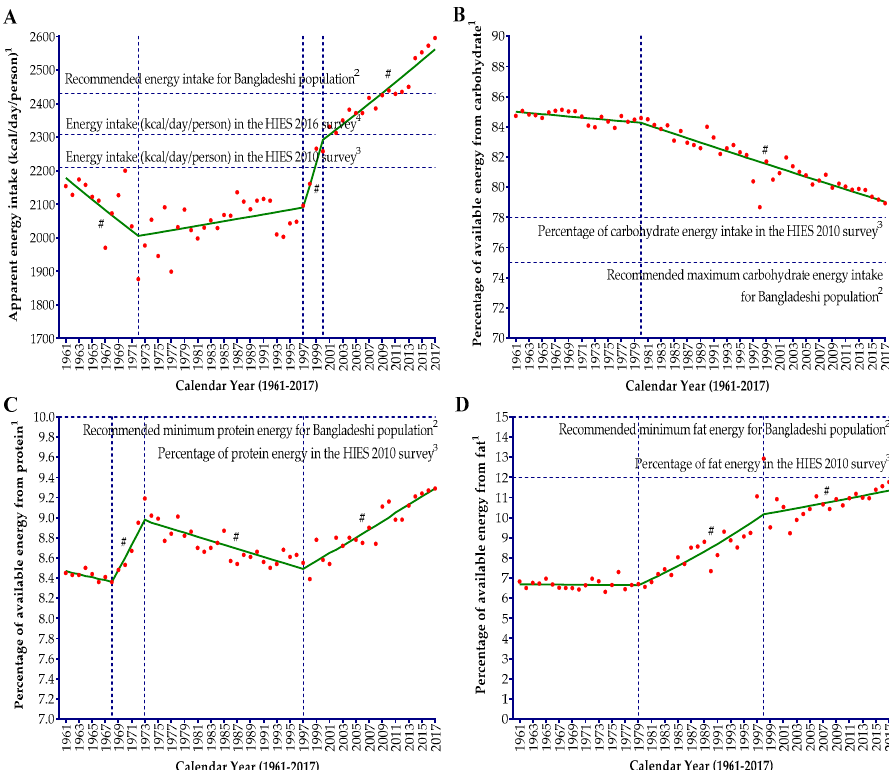
Figure 1. Joinpoint regression analysis of the apparent intake of energy ( A ) and the percentage of available energy from carbohydrates ( B ), protein ( C ), and fat ( D ) in the diets of the Bangladeshi population from 1961 to 2017. A vertical dotted line represents the joinpoints. 1 Apparent energy intake refers to the average availability of energy in the diets for consumption and percentage of available energy from carbohydrates ( B ), protein ( C ), and fat ( D ). 2 A horizontal dotted line represents the recommended energy intake and recommended percent distribution of available energy from macronutrients on the basis of the desirable dietary pattern (DDP) for the Bangladeshi population [23]. 3 A horizontal dotted line represents the mean actual energy intake (kcal/day/person) and macronutrient distribution to energy (carbohydrates ( B ), protein ( C ), and fat ( D )) in the diet of the Bangladeshi population on the basis of the dietary analysis of the Household (Income and) Expenditure Survey (H(I)ES) in 2010 [23]. 4 A horizontal dotted line represents the mean per capita actual energy intake (kcal / day) in the diet of the Bangladeshi population on the basis of the dietary analysis by the Bangladesh Bureau of Statistics (BBS) of the latest H(I)ES in 2016 [27]. # denotes the annual percent change (APC) that is significantly di ff erent from 0 ( p <